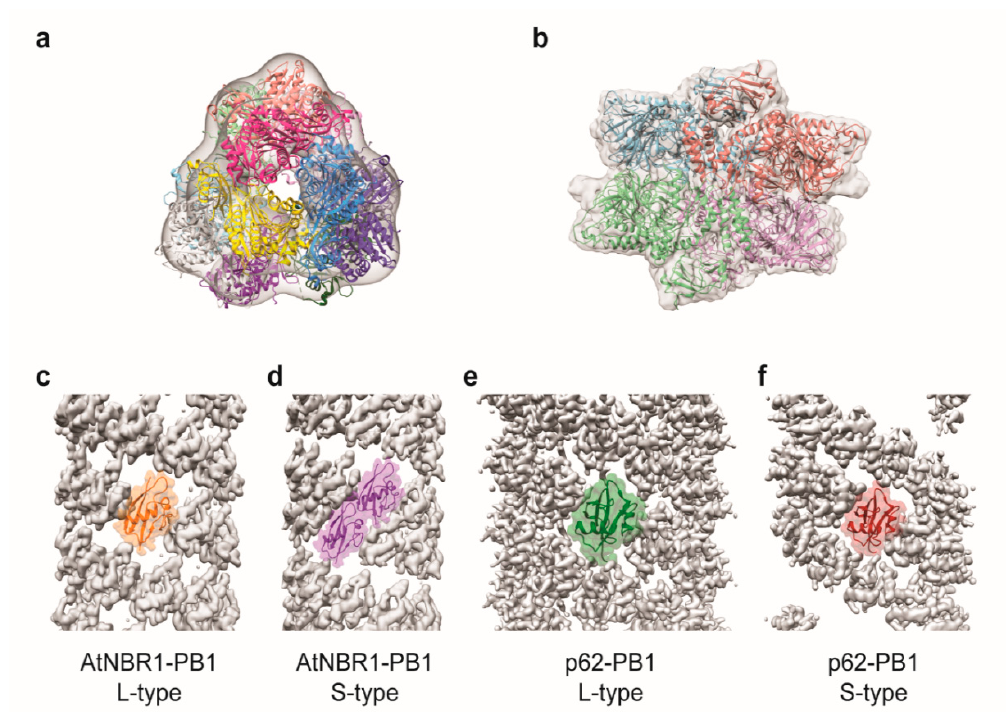
Figure 4. 3D EM reconstructions of selective autophagy components. ( a ) Crystal structure of S. cerevisiae mApe1 (PDB: 5JM9) fitted into the cryo-EM map of S. cerevisiae mApe1 dodecamer (EMD-8167). Each chain is shown in a different color. ( b ) Crystal structure of S. cerevisiae Ams1 (PDB: 5JM0) fitted into a cryo-EM map of S. cerevisiae Ams1 tetramer (EMD-8166). Each chain is shown in a different color. ( c – f ) Cryo-EM reconstruction of Arabidopsis thaliana NBR1 (AtNBR1) PB1 domain and p62-PB1 domain filaments, with each of the crystal structure fitted into the cryo-EM map of the filament subunit. (c) AtBNR1-PB1 monomer (in orange) (PDB: 6TGN) in AtBNR1-PB1 L-type filament (EMD-10499). (d) AtBNR1-PB1 homodimer (in purple) (PDB: 6TGP) in AtBNR1-PB1 S-type filament (EMD-10500). (e) p62-PB1 monomer (in green) (PDB: 6TGY) in p62-PB1 L-type filament (EMD-10501). (f) p62-PB1 monomer (in red) (PDB: 6 TH 3) in p62-PB1 S-type filament (EMD-10502).